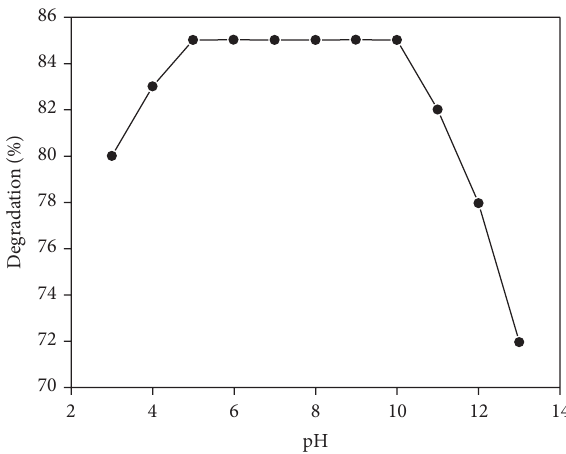
Figure 7: Influence of pH on the degradation of the dye. (Figure 7 is reproduced from reference [27]. Copyright 2002, with permission from